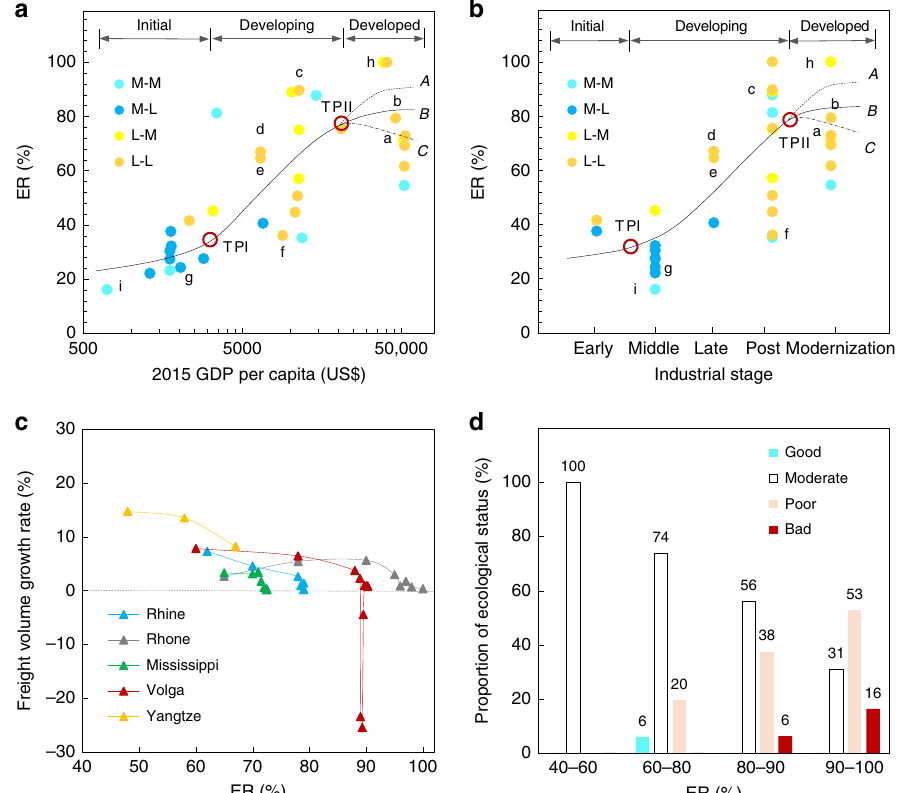
Fig. 4 Exploitation ratios (ER) and threshold of representative Golden Inland Waterways (GIWs). ER (%) is the ratio of actual to idealized bearing capacity. a , b Basin-average ER of various GIWs (small letters a-i corresponding to the nine representative waterways in Fig. 3) at different development stages in terms of 2015 GDP per capita (in 2010 US$) and industrialization stage in 2015, respectively. The two turning points (TPI, TPII) separating the three stages are marked by red hollow circles. GIWs at the developed stage after the TPII show diverse ER (58 – 100%) as the consequences of different development strategies (A, radical; B, moderate; and C, conservative). c Freight volume growth rate (%) under varying ER for six typical GIWs. d Proportion of reaches with different levels of ecological status, corresponding to varying ER from 134 reaches of six European GIWs. Source data are provided as a Source Data fi